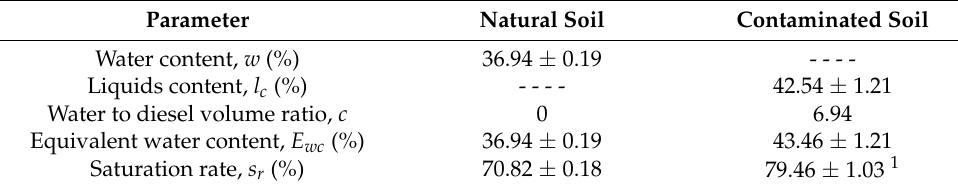
Values in the table: mean value ± standard deviation ( n = 3). 1 The s r of the contaminated soil was calculated using E wc instead of w